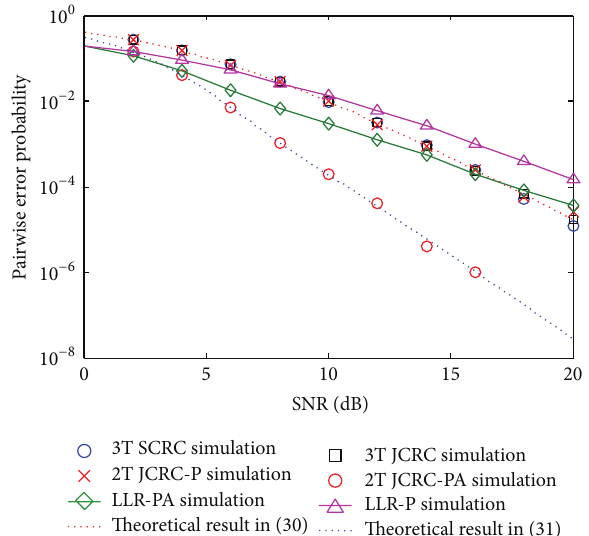
Figure 5: PEP comparisons between theoretical results and simula-